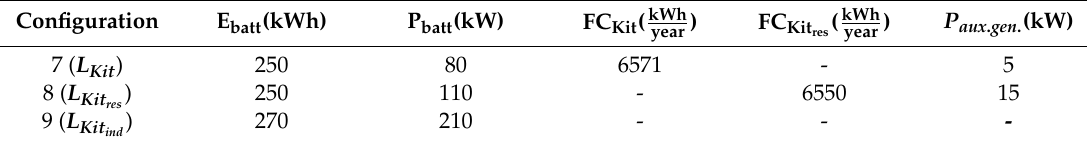
Table 5. Analyzed VRFB configurations.